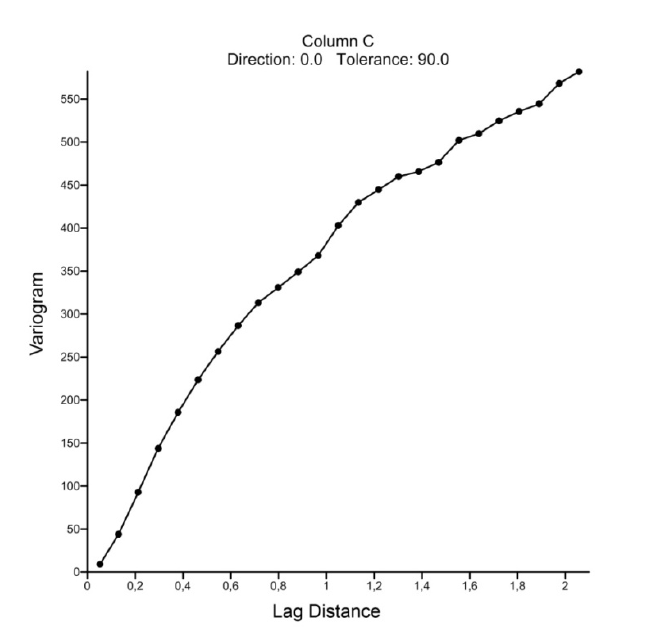
Fig. 3. The empirical variogram of Grodziec area